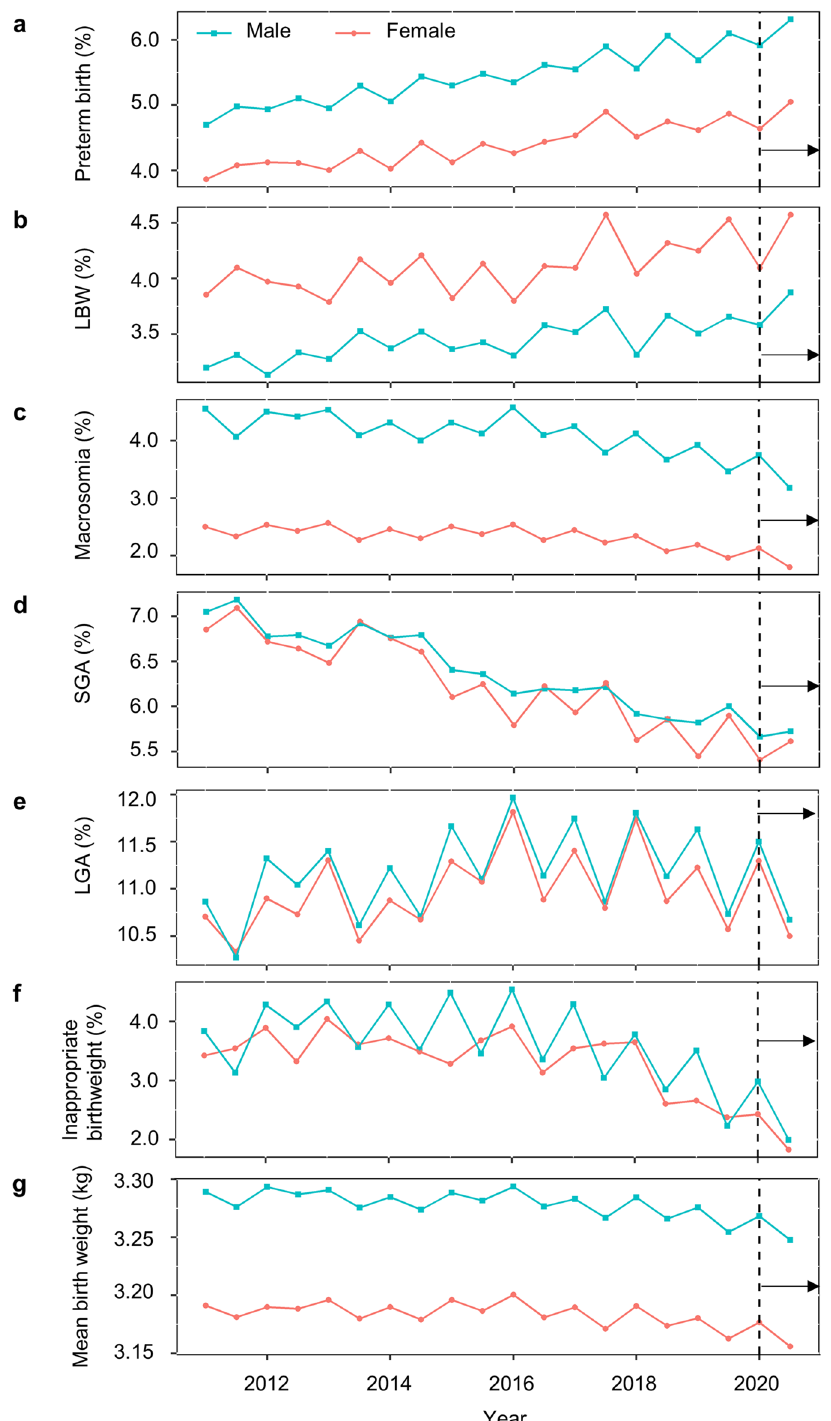
Figure 1. Long-term trends of inappropriate birth outcomes in South Korea. Rates of preterm births ( a ), Low Birthweight, LBW ( b ), Macrosomia ( c ), Small for Gestation Age, SGA ( d ), Large for Gestation Age, LGA ( e ), Inappropriate birthweights ( f ), and Mean birthweights ( g ) from 2011 to 2020. Females and males are represented in red circles and blue squares, respectively. In chi-squared tests for trend in proportions, all rates ( a – f ) for both sex had increasing ( a , b , e ) and decreasing ( c , d , f ) trends with p < 0.001 from 2011 to 2020. Mean birthweights ( g ) had decreasing trend with p = 0.005 for males and p = 0.002 for females by Pearson’s product- moment test. The SARS-CoV-2 pandemic started at the beginning of 2020, indicated by dashed black vertical lines and solid